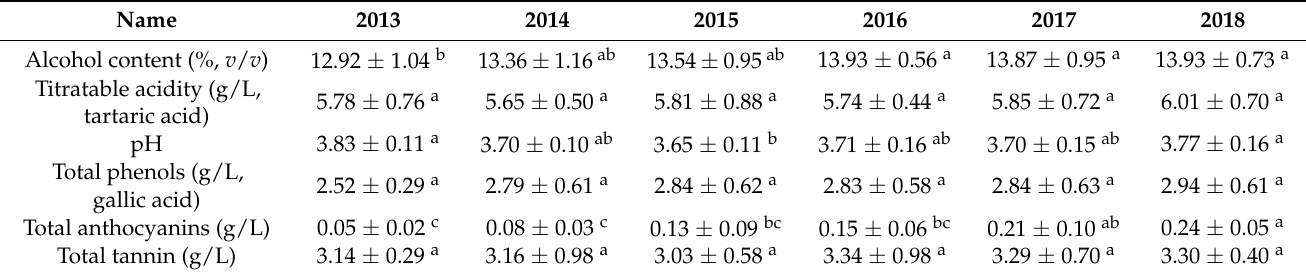
Table 2. Oenological parameters of red wine from the six vintages (2013–2018) in the Ningxia region. ( p <